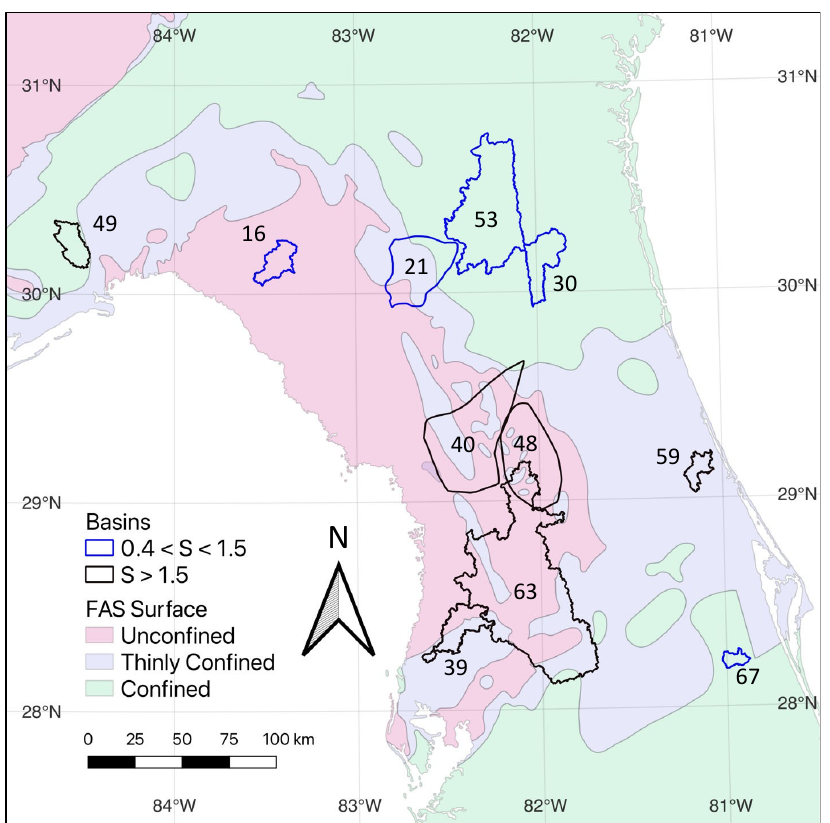
Figure 5. Distribution of estimated storage coefficients using the ∆ℎ and ∆𝑉 time series. Note that NSI storage coefficients are 0–0.4, SSI storage coefficients are 0.4–1.5, and SI storage coefficients are >1.5.